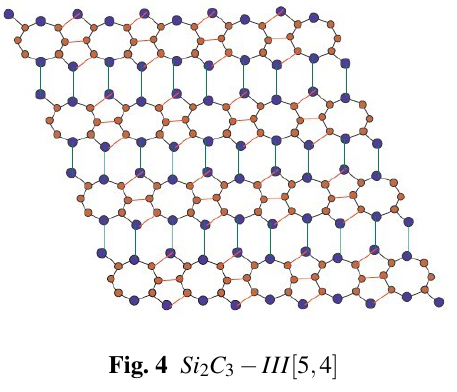
Fig. 4 Si 2 C 3 − III [ 5 , 4 ]